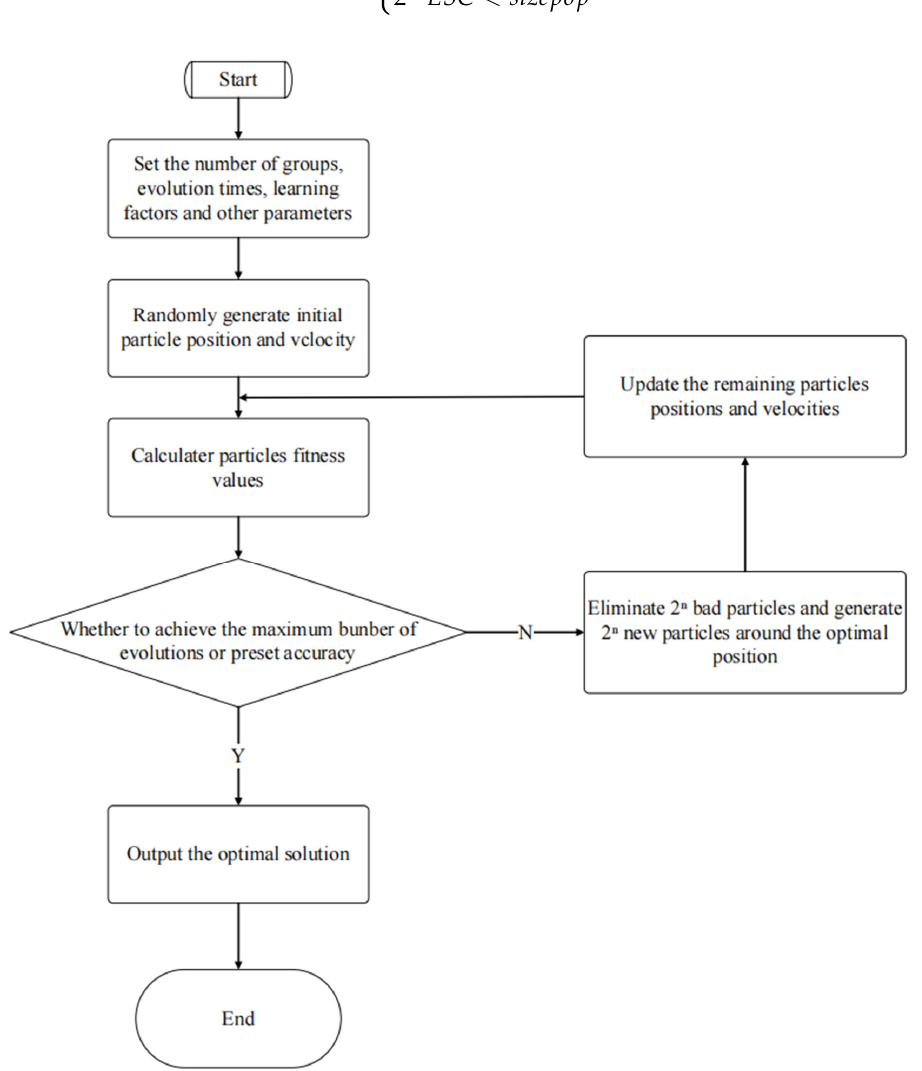
Figure 11. Improved PSO flow chart, showing the basic process of the improved PSO.